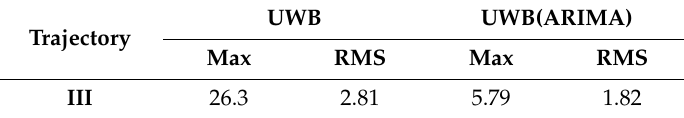
Table 3. Statistics of Euclidean Distance Errors in Trajectory III (m).